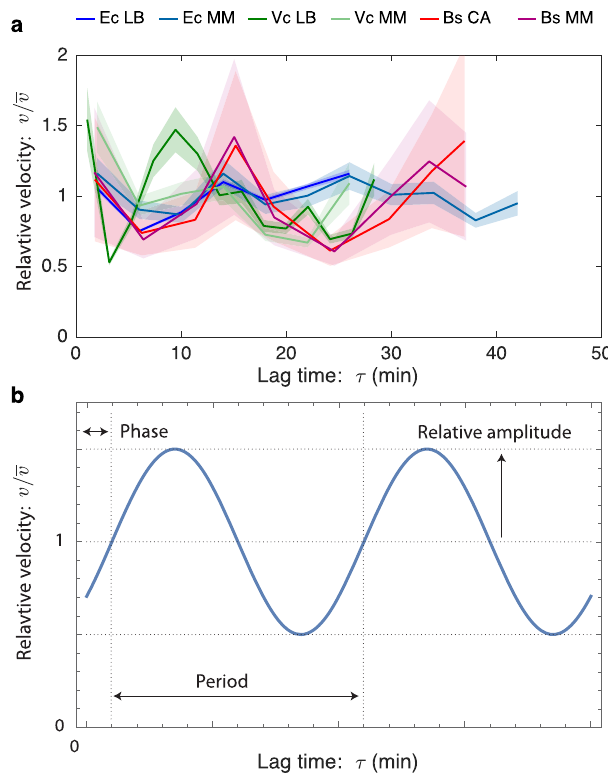
Fig.6|Fork-velocityoscillations.a Temporalvelocityoscillationsareobservedin three bacterial species: E. coli (Ec), B. subtilis (Bs), and V. cholerae (Vc). The fork velocity starts high before decaying rapidly and then recovering. Data are pre- sented as mean values±SEM. b Oscillation characteristics. The de fi nition of the phase, amplitude, and period of the fork velocity oscillation. Table 2 | Velocity oscillation characteristics for different bacterial species and growth conditions Organism Growth Period condition (min)